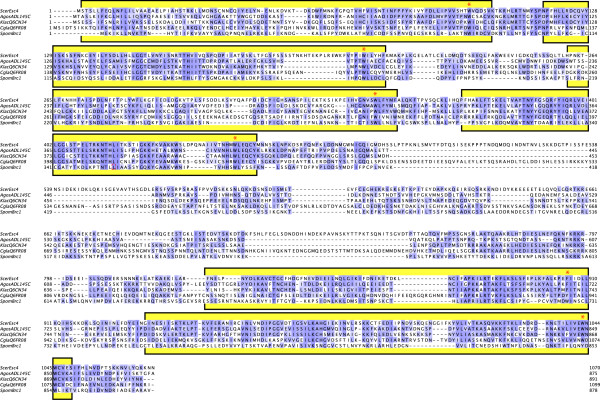
Saccharomyces cerevisiae Esc4 has six BRCT motifs that are conserved in both sequence and domain architecture among yeast homologs. The six BRCT motifs in Esc4 are indicated with brackets and yellow color and were described previously [49]. The motifs in Esc4 are shown as they align with a subset of Esc4 homologs: three from other budding yeasts Ashbya gossipii, Kluyveromyces lactis and Candida glabrata and one from the evolutionarily distant fission yeast Schizosaccharomyces pombe Brc1. The highly conserved aromatic residue, a hallmark of BRCT motifs, is marked above the alignment with a red asterisk. Blue color indicates similarity with the predominant residue at the position in the alignment, with darkness correlated with greater similarity as calculated by ClustalW software and displayed with Jalview alignment editor's BLOSUM62 score viewing option [67, 68].